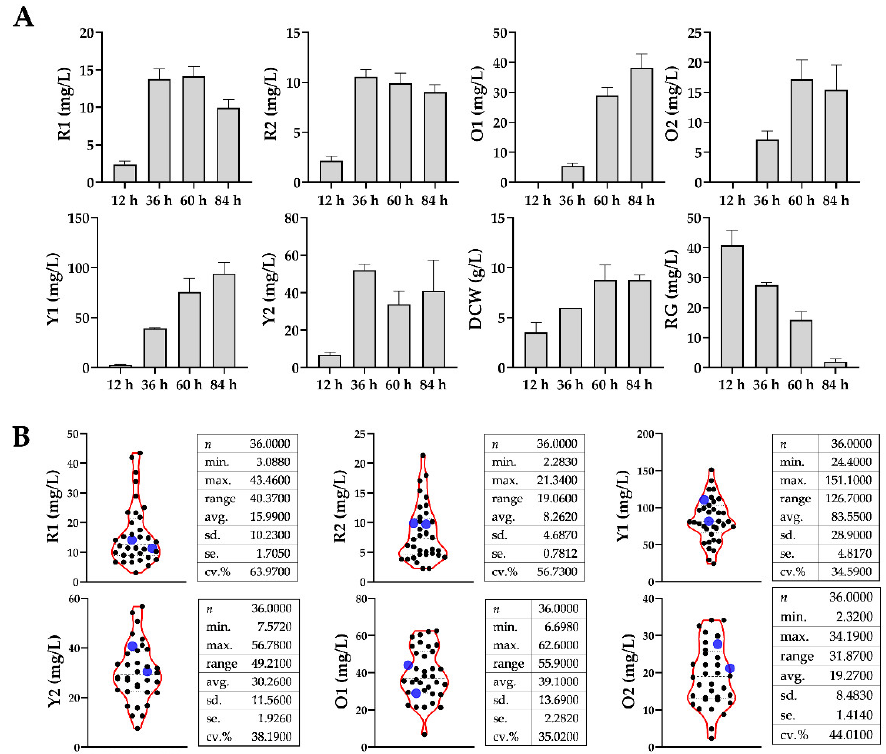
Figure 2. ( A ) Time-coursed characterization of Monascus pigment production, biomass, and glucose consumption in the control group. The error bar represents the standard deviation of three independent experimental data. RG, residual glucose in the fermentation broth. ( B ) Distribution of pigment production at 60 h under metabolic perturbations with different amino acids. n, number of samples; min., minimal value; max., maximum value; range, data variation range (max.–min.); avg., average value; sd., standard deviation; se., standard error; cv., coefficient of variance.